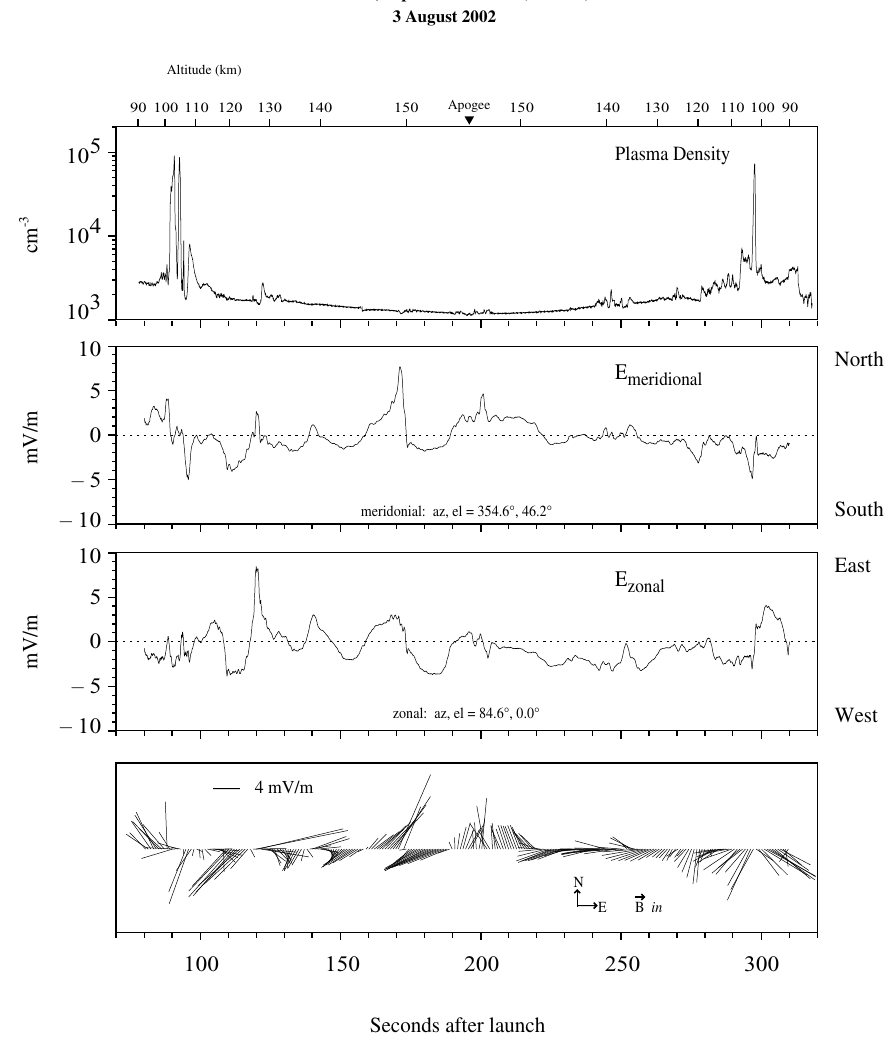
Fig. 7. The DC electric field solution in magnetic coordinates with the plasma density shown in the uppermost panel.